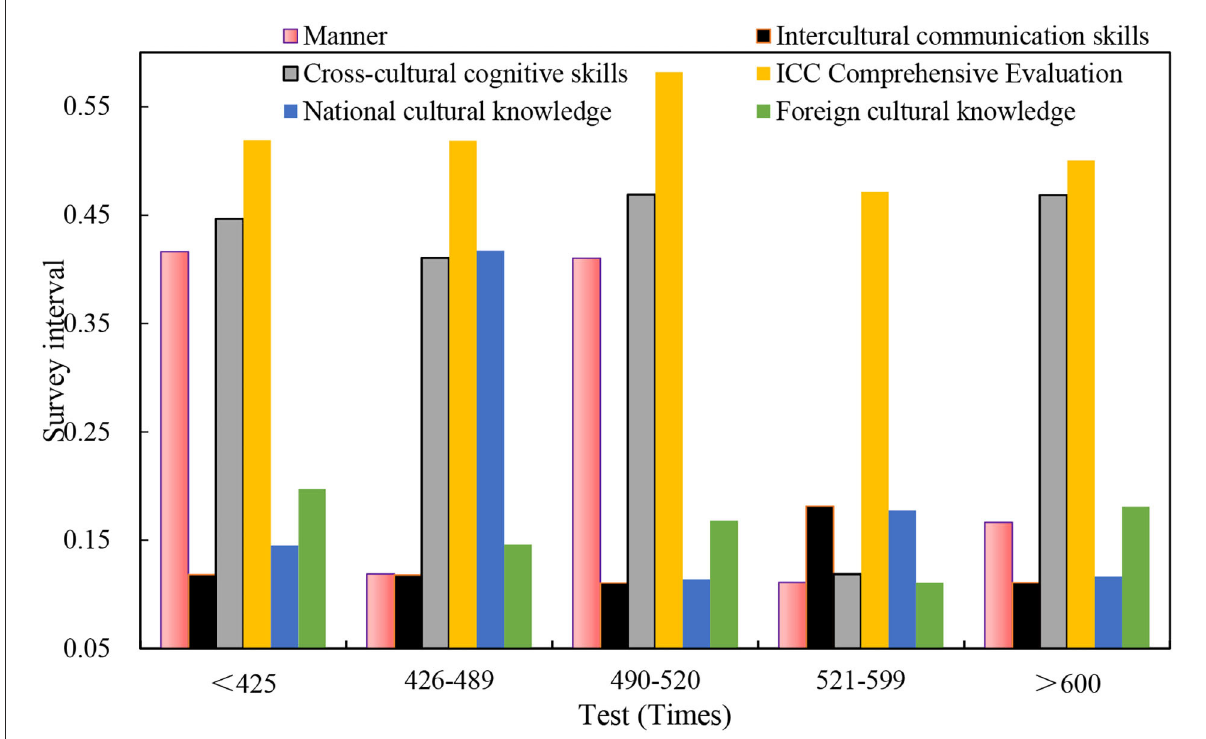
FIGURE8 Impact of different CET-4 performance and cross-cultural communicative competence.